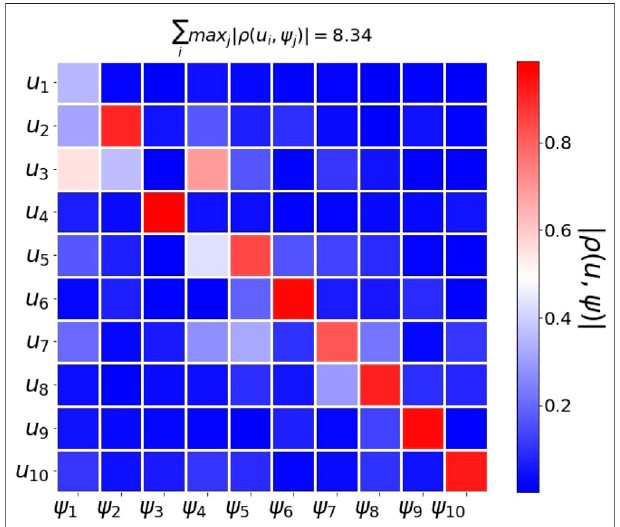
FIGURE 9 | Word2vec embedding of samples from multiclass MNIST. We use 10,000 samples drawn from the MNIST handwritten dataset. The fi gureshowstheabsolutecorrelationbetweenthe u This results provide another empirical evidence that the eigenvectors of 1 are a good proxy for word2vec P − 1 n